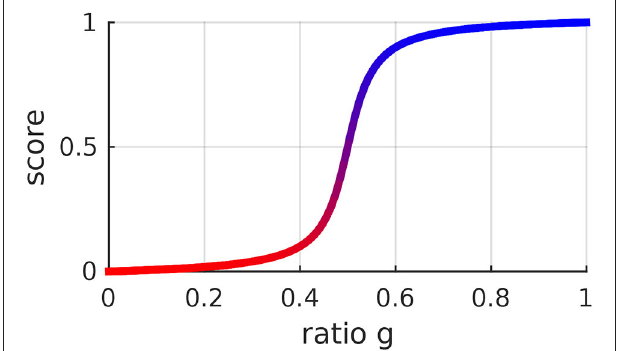
FIGURE 4 | Score function of the ratio g between the probability of a certain position and the probability of the corresponding position along the mean trajectory. This function is determined by (21) and was designed to be 0 when g = 0, 1 when g = 1 and to monotonically increase with g . It is possible to change the steepness of this function by changing its hyperparameter b . The same color code as in this figure is used to give visual feedback to the